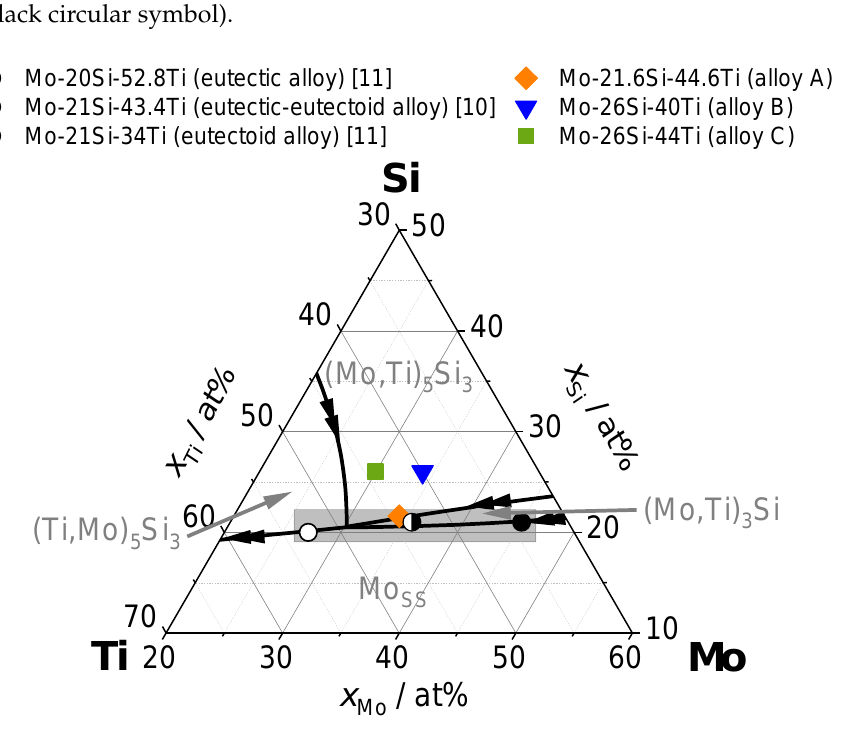
Figure 2. Metal-rich portion of the liquidus projection of the ternary Mo-Si-Ti system with highlighted chemical compositions of the here investigated alloys (coloured symbols) in comparison to former presented alloys (black/white circular symbols). The region with a Si content of around 20 to 21 at.% is highlighted by a grey rectangle symbolising the region of former research in Refs. [5,10] on eutectic-eutectoid Mo-Si-Ti alloys by Obert et al..